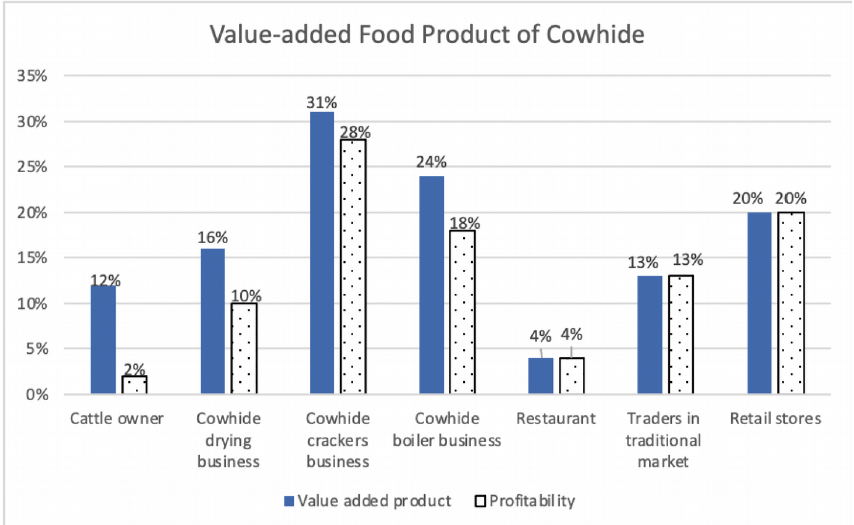
Figure 5. Value-added of food product